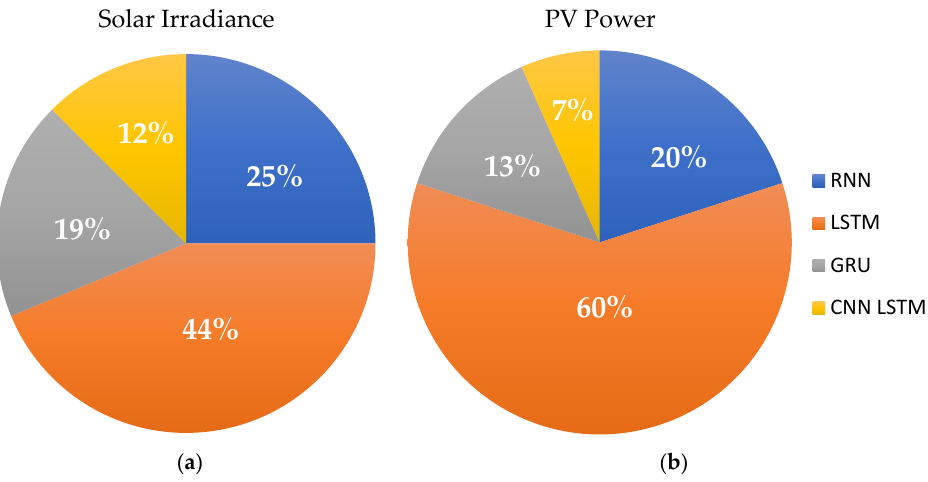
Figure 10. Distribution of studies using deep learning models to predict ( a ) solar irradiance and ( b ) PV power.